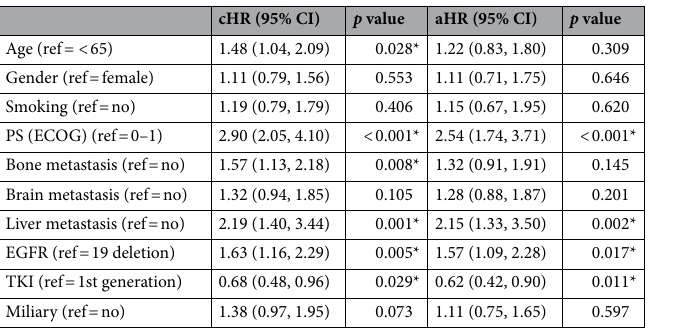
Table 4. Associations between miliary and OS. ref: reference, PS: performance status, ECOG: Eastern Cooperative Oncology Group, CI: confidence interval, cHR: crude hazard ratio, aHR: adjusted hazard ratio, * p value <